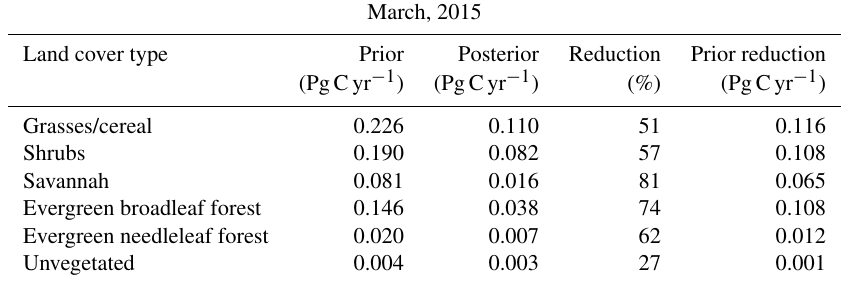
Table D2. Sensitivity case (2): uncertainty reduction of total CO 2 Australian flux (in PgCyr − 1 ) classified by MODIS ecotype (March, 2015).